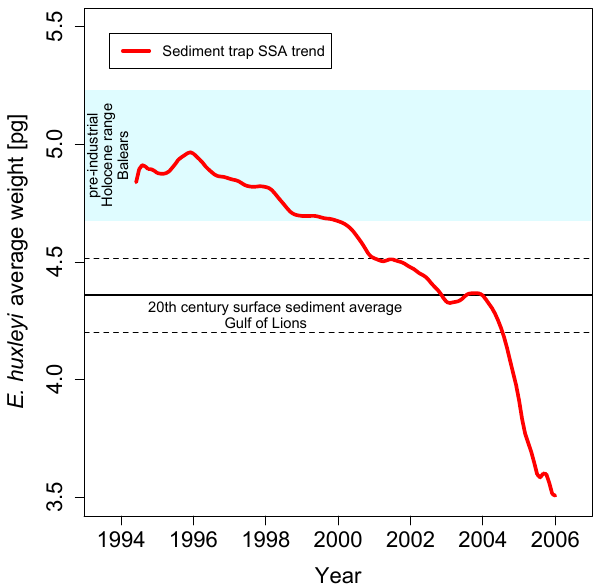
Figure 9. Comparison of sediment trap with sediment data. Emil- iania huxleyi SSA trend in coccolith weight values from the sedi- ment trap in the Gulf of Lions in comparison with sediments from a 20th century sediment surface (dashed lines indicating 95% confi- dence interval), and a pre-industrial Holocene sediment record (blue shaded area indicating range of average weight values) from the NW